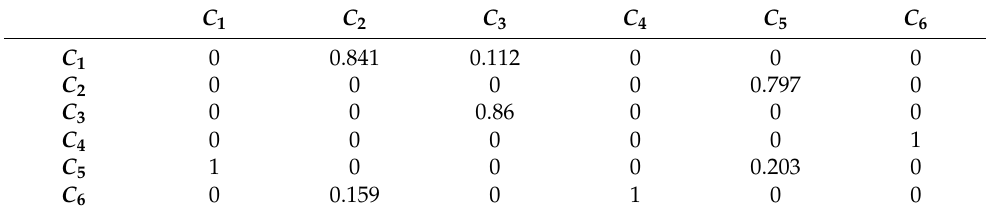
Table 6. Degree of relative impact for criteria.